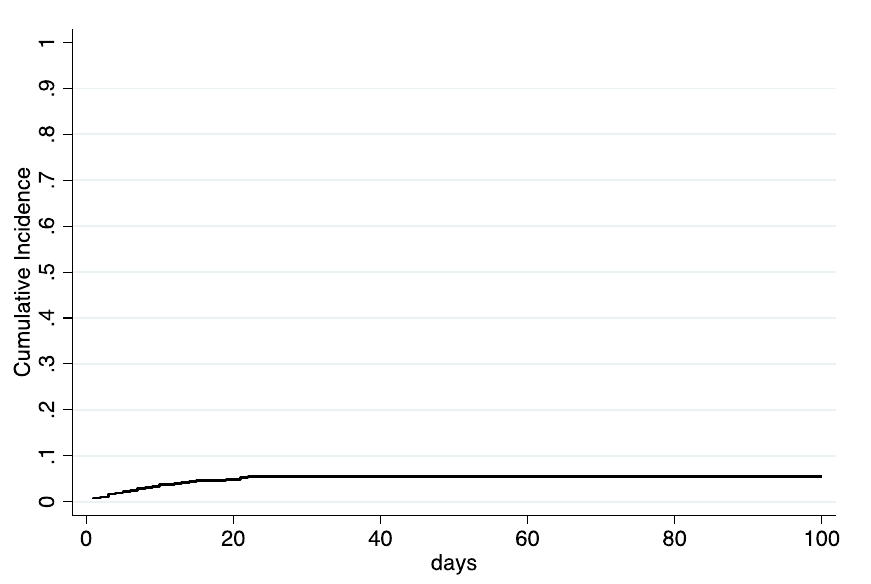
Figure 1. Cumulative incidence of CDI after HSCT. CDI = clostridium difficile infection; HSCT = hematopoietic stem cell transplantation.